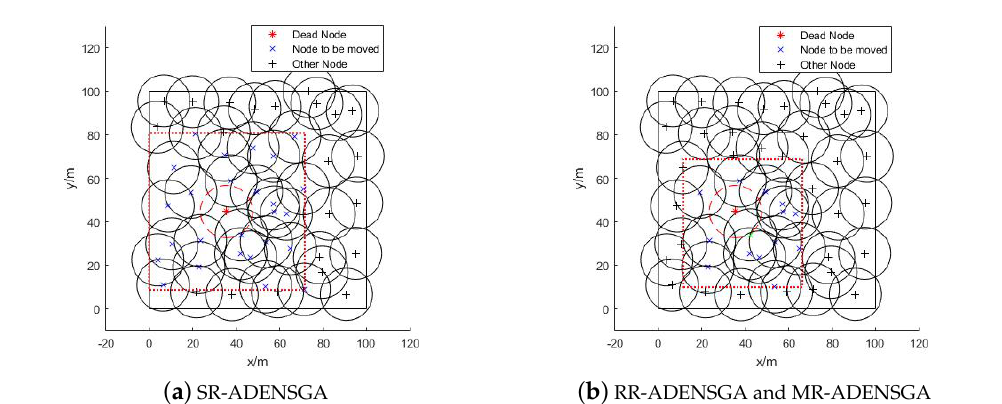
Figure 6. Optimization Region and Position of Nodes to be Moved in Situation